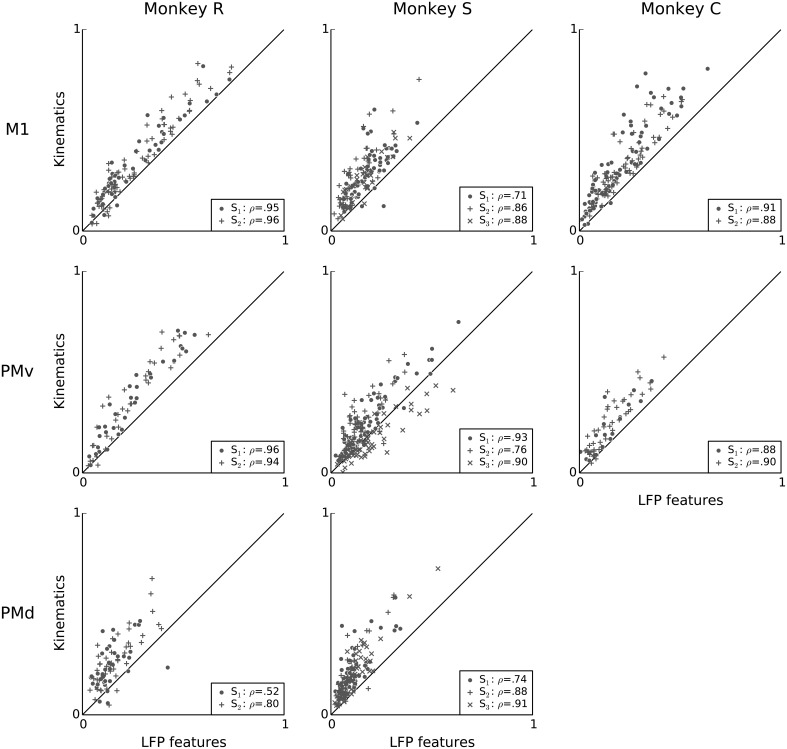
Kinematics and features of ongoing and evoked multiband LFP oscillations achieve similar predictive power on a neuron by neuron basis. Scatter plots compare the predictive power of LFP features (x-axis) to that of kinematic features (y-axis). LFP features include the instantaneous phase, amplitude envelope, and analytic signal, in the δ = 0.3–2 Hz, θ = 2–7 Hz, α = 7–15 Hz, and β = 15–30 Hz LFP bands, as well as amplitude envelope and analytic signal in the γ1 = 30–60 Hz, γ2 = 60–100 Hz, MUA1 = 100–200 Hz, and MUA2 = 200–400 Hz bands (see Methods: LFP feature extraction). Each data-point is a single unit from one session. The dashed line indicates equality. Most units lie above the dashed line, indicating that kinematic features better predict single-unit spiking variability. In the figure legends, “S” indicates the session, ρ is the Pearson correlation coefficient between the predictive power for kinematics and LFP features. Predictive power from both LFP and kinematics are highly correlated, i.e., neurons that are well predicted by LFP features tend also to be well predicted by kinematics.